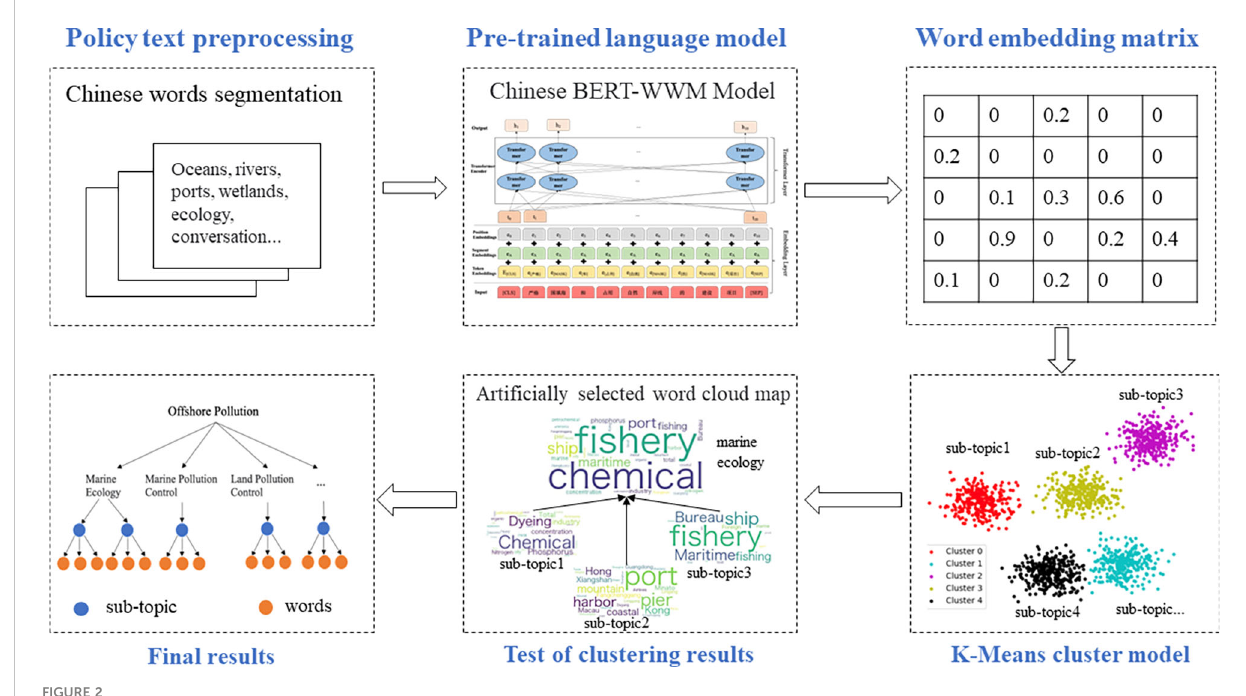
FIGURE 2 The process of generating different themest.